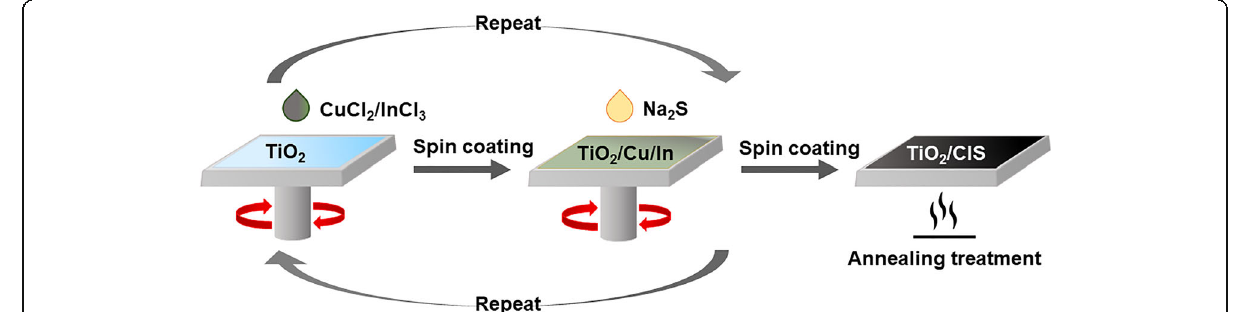
Fig. 2 Schematic of the process for fabricating CIS QD-sensitized TiO 2